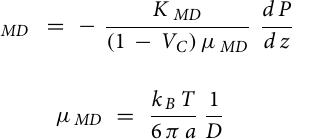
Figure 1. Permeability evaluation of water outside CNTs using MD 15 ( a ) Axial pressure gradient between the CNTs at intervals of 0.2 nm. d P /d z was calculated by evaluating the pressure within several sub-volumes along the CNT axis and performing a linear regression analysis. ( b ) Analytical models and permeating behavior. VACNFs was made by applying the periodic boundary condition and permeating water outside CNTs. The figures ( a ) and ( b ) are created by VMD (version: 1.9.3, https ://www.ks.uiuc.edu/Resea rch/vmd/). ( c ) Permeability versus V C . The permeability was divided into three regions as a trend: region I (orange circle, V C ≦ 0.106), the influence of the slip was small and the permeabilities decreased with increasing V C ; region II (blue circle, 0.188 ≦ V C ≦ 0.361), permeability increased or decreased with increasing V C ; and region III (black circle, V C ≧ 0.424), the area indicated the opposite tendency of region